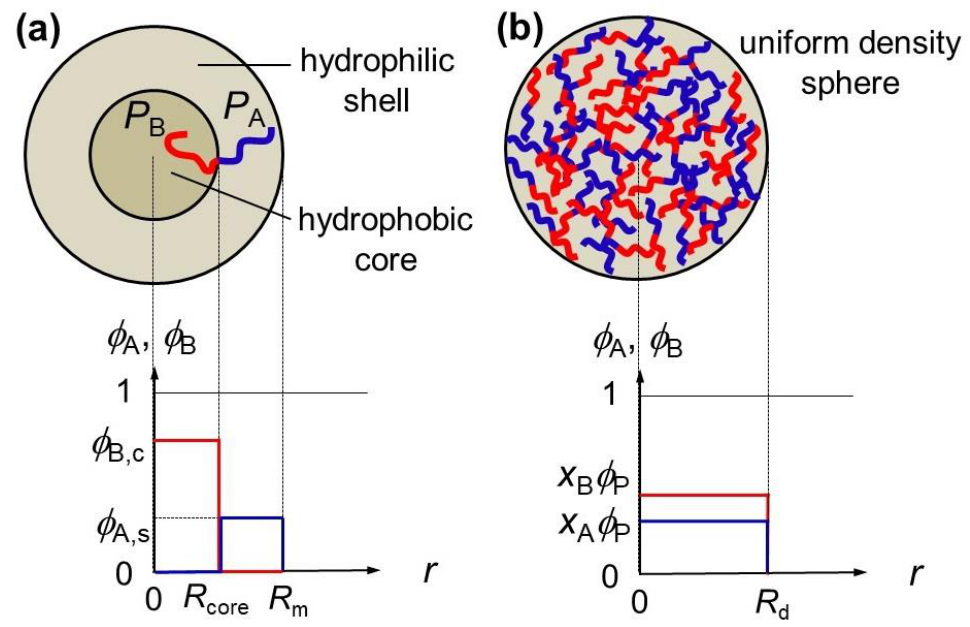
Figure 1. Simplified model of the spherical micelle ( a ) and the uniform density spherical model of the concentrated-phase droplet ( b ).